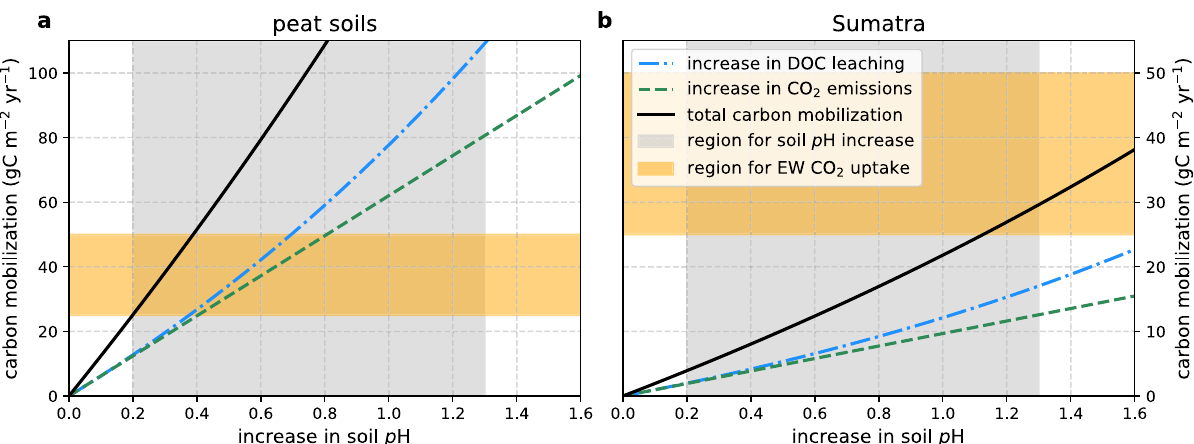
Fig. 1 Soil emission response to enhanced weathering. Carbon mobilization for basalt application of 1 kg m − 2 year − 1 on a peat soils (case 1) and b all of Sumatra ’ s soils (case 2). Regions for the EW-induced soil pH increase and CO 2 uptake are estimated based on EW studies for tropical soils 8,9 . The pH dependences of CO 2 and DOC mobilization are based on data from a study on peat soils